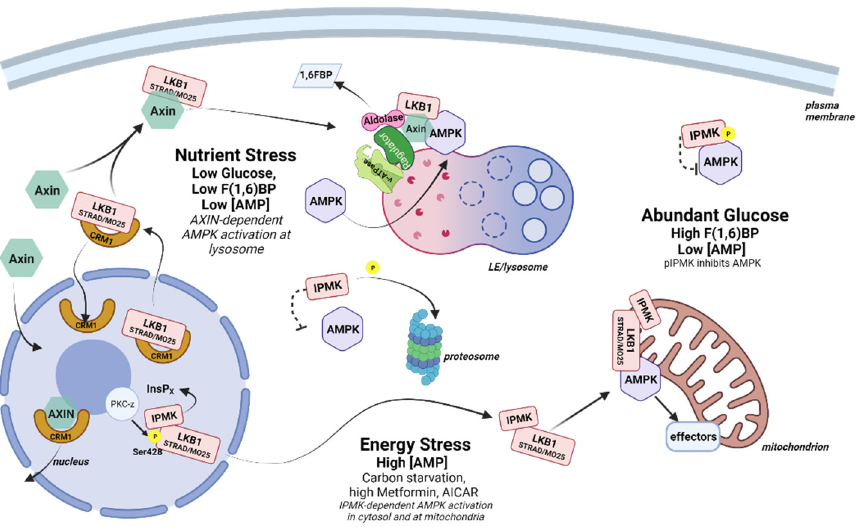
Figure 3. AMPK regulation by IPMK. In cells with abundant glucose, IPMK is phosphorylated and binds to AMPK, blocking activation by LKB1. When cells experience low glucose levels, IPMK is dephosphorylated, releases AMPK, and is subsequently degraded, leaving AMPK free to translocate to the late endosome/lysosome. AXIN, a nuclear/cytoplasmic shuttling protein, binds to the LKB1 complex and transports it to the lysosome, where AXIN interacts with aldolase and bridges LKB1 with lysosomal AMPK for activation. Under conditions of severe energy stress, IPMK activity is necessary to enable the LKB1 complex to exit the nucleus, possibly by facilitating the phosphorylation of LKB1 by PKC ζ . The LKB1 complex is free to associate with and activate cytosolic and mitochondrially localized AMPK. Created with BioRender.com, accessed on 27 May